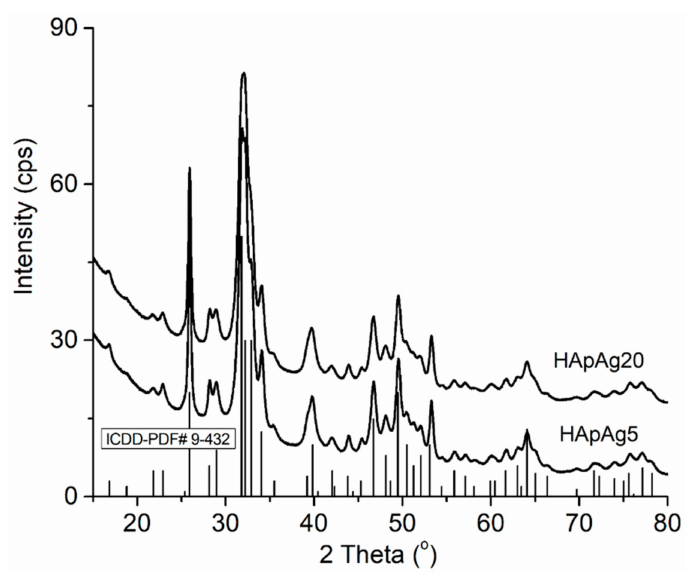
Figure 1. XRD pattern of the HApAg5 and HApAg20 samples and the standard pattern of the HAp